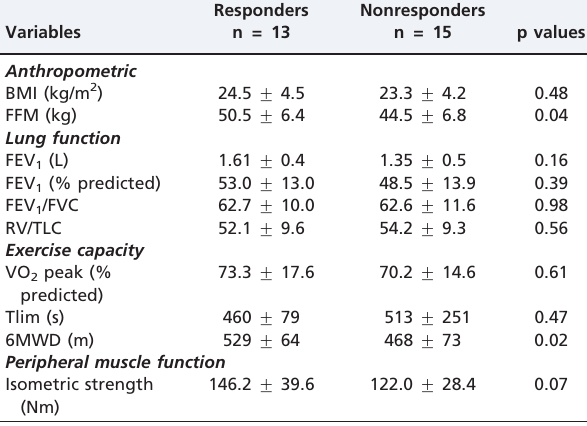
Table 3 - Baseline characteristics of body composition, pulmonary function, exercise capacity and peripheral muscle strength in responders and nonresponders to hf- NMES according to changes in exercise endurance